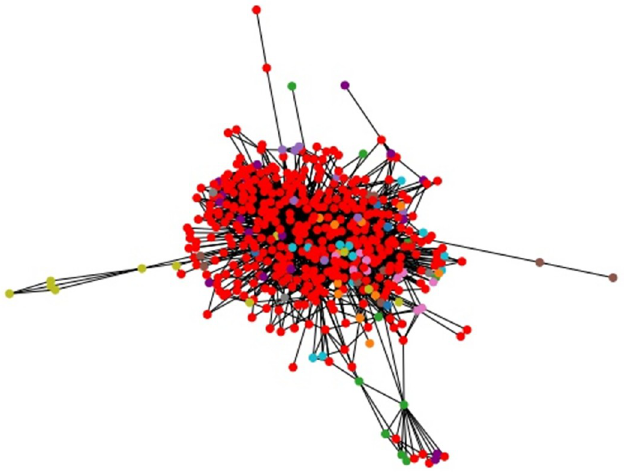
Fig 11. C. metabolic community structure. Community structure obtained by LSE heuristic with W 0 parameters n = 10, p = c